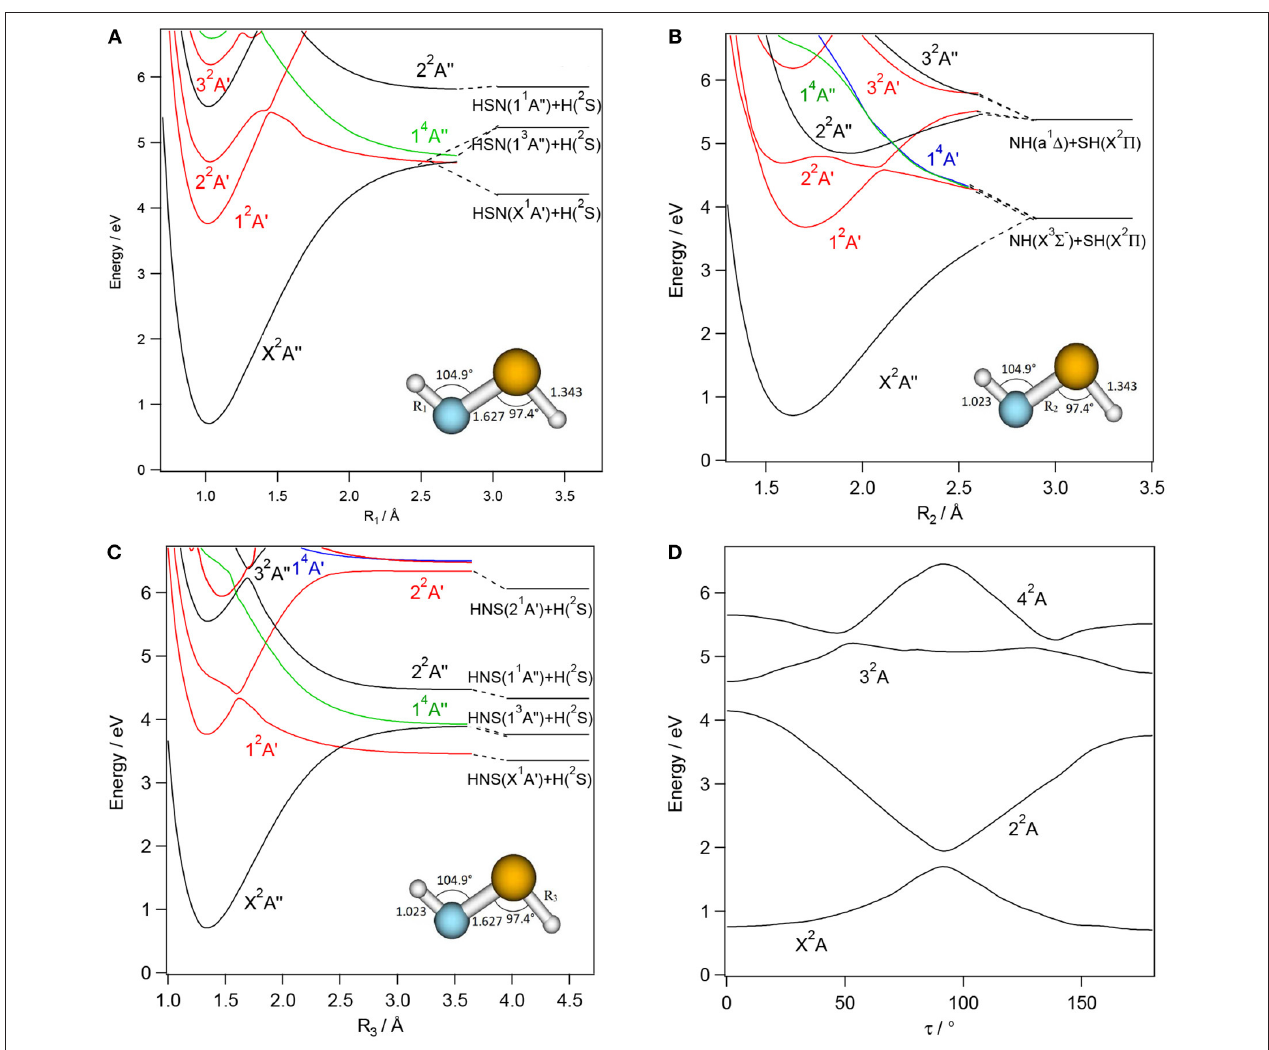
FIGURE 4 | CASSCF/MRCI/aug-cc-pV(5 + d)Z one-dimensional cuts of the 6D-PESs of the low lying electronic states of trans- HNSH along the SH (R 1 , A ), NS (R 2 , B ), and NH (R 3 , C ) stretching and τ torsion, (D) coordinates. The remaining internal coordinates are kept fixed at their values in the trans- HNSH(X 2 A ′′ ) state i.e., R 1 = 1.023 Å, R 2 = 1.627 Å, R 3 = 1.343 Å, θ 1 = 104.9 ◦ θ 2 = 97.4 ◦ , and τ = 180 ◦ . The H + HNS/HSN, NH + SH asymptotes are located using the data in Supplementary Tables 8 , 9 and ( Trabelsi et al., 2015) 1 . The reference energy is that of H 2 NS(X 2 B 1 ) at